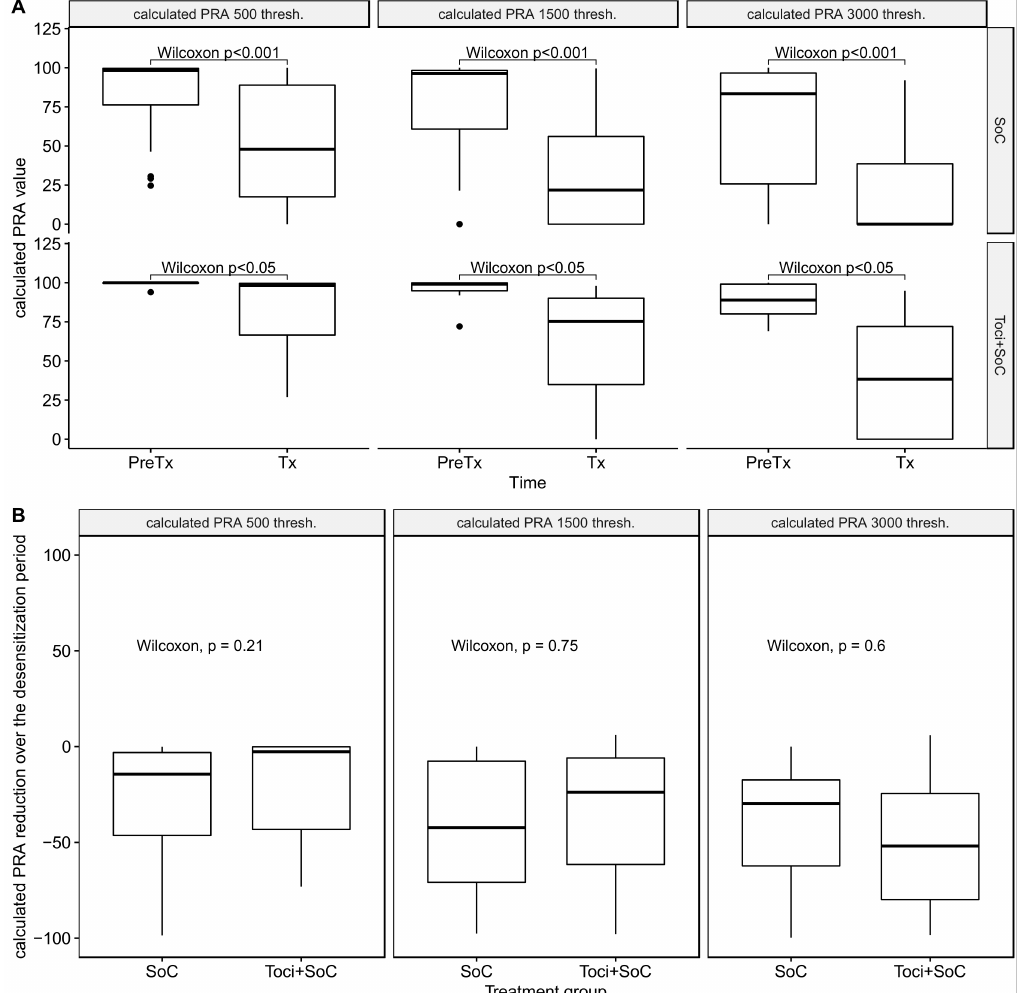
Figure 3. Evolution of calculated panel-reactive antibodies (cPRA), with different MFI threshold for antibody positivity. ( A ) Evolution of cPRA through the desensitization process, by treatment group and by cPRA definition. ( B ) Comparison of cPRA reduction by treatment group, by cPRA definition. SoC group: 26 patients; Toci + SoC group: 7